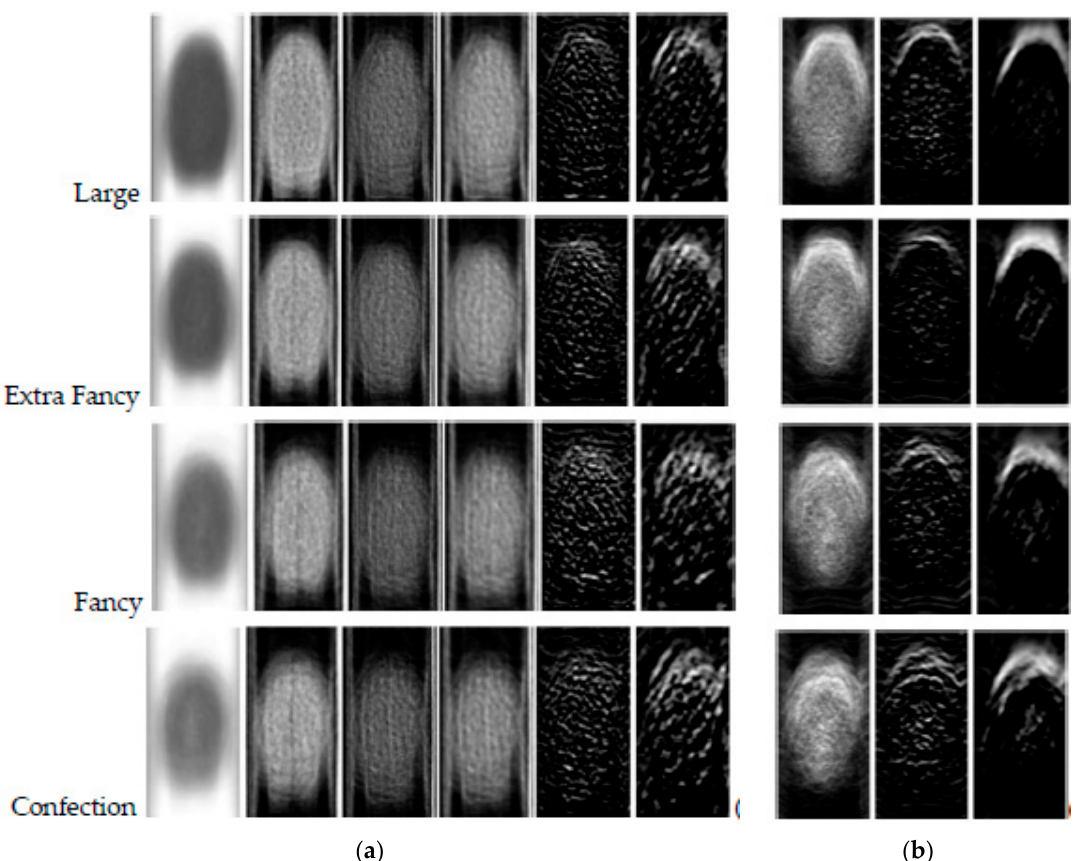
Figure 10. Visualization of two sample features that consist of ( a ) six transforms and ( b ) three transforms.